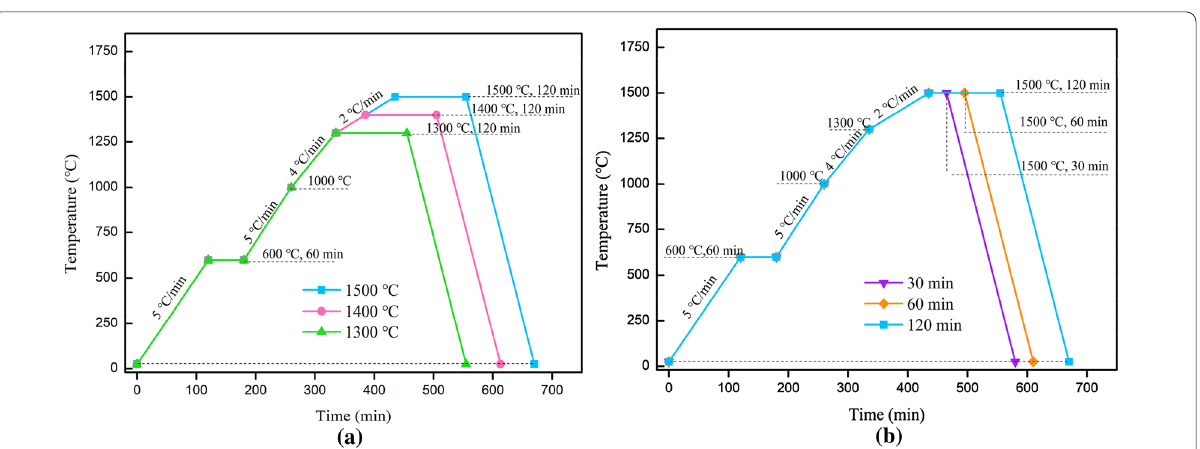
Fig. 2 The pyrolysis curve for the preparation of R–SiC at a different temperatures; b different retention